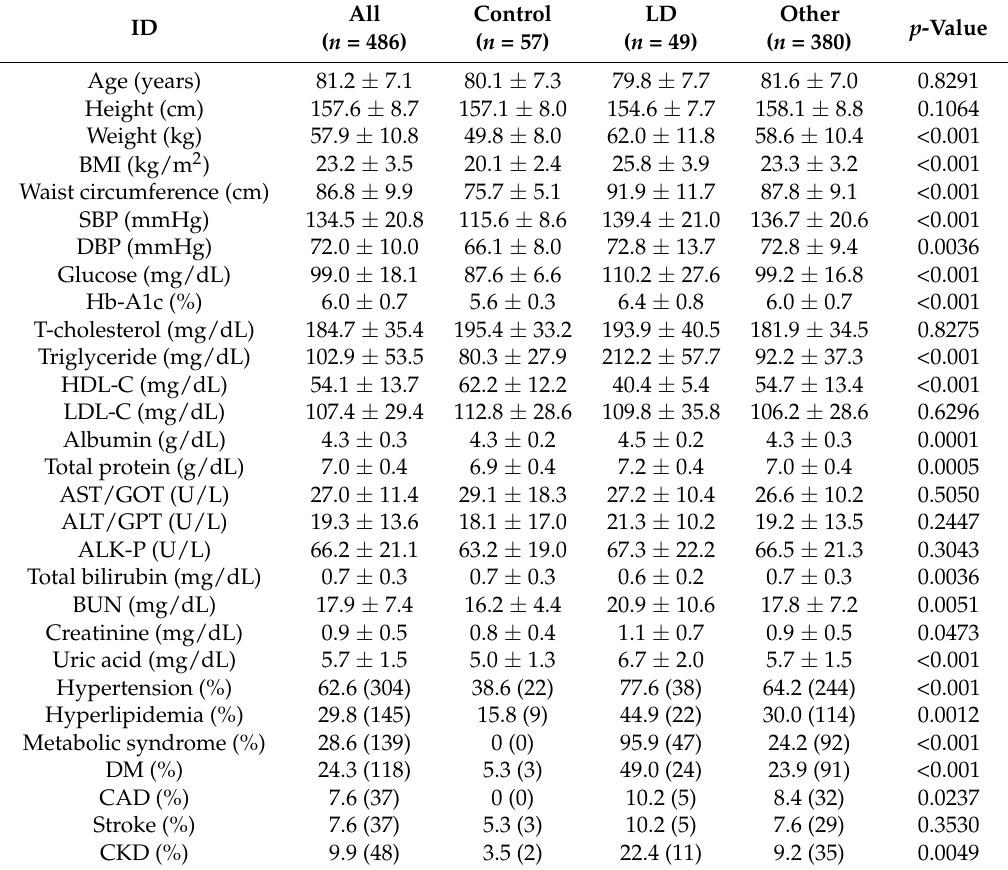
Table 1. Demographic and laboratory data for an elderly Taiwanese